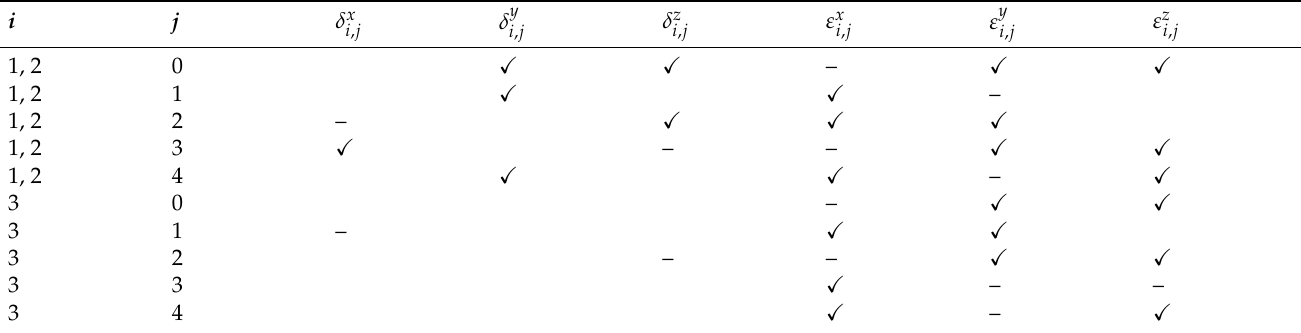
Table 6. Initially identified internal-force-and-deformation-related geometric